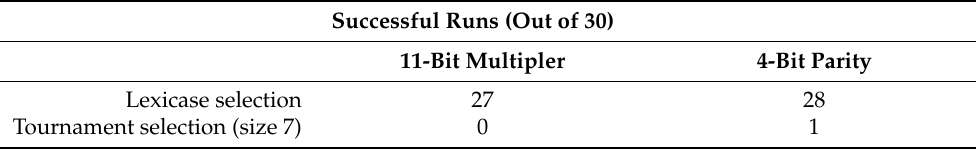
Table 5. Number of successful runs in the 11-bit Multiplexer and 4-bit Parity